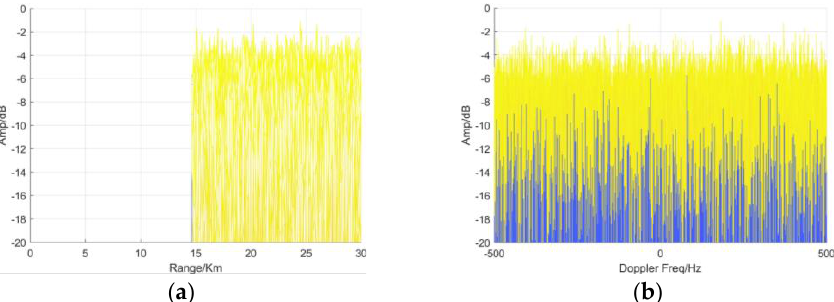
Figure 10. The CI after the ECA: ( a ) the range – amplitude plane; ( b ) the Doppler frequency – amplitude plane.